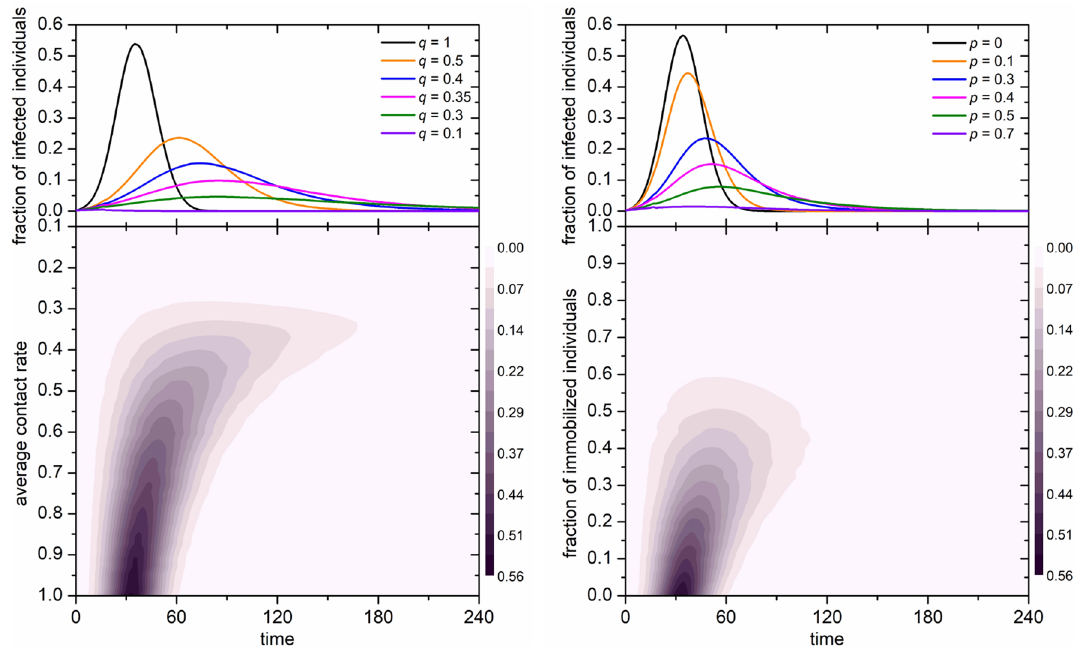
Figure 2. Simulated epidemic curves based on a susceptible-exposed-infectious-recovered (SEIR) model obtained by averaging outcomes over 1.5 million nodes in network configurations representing social